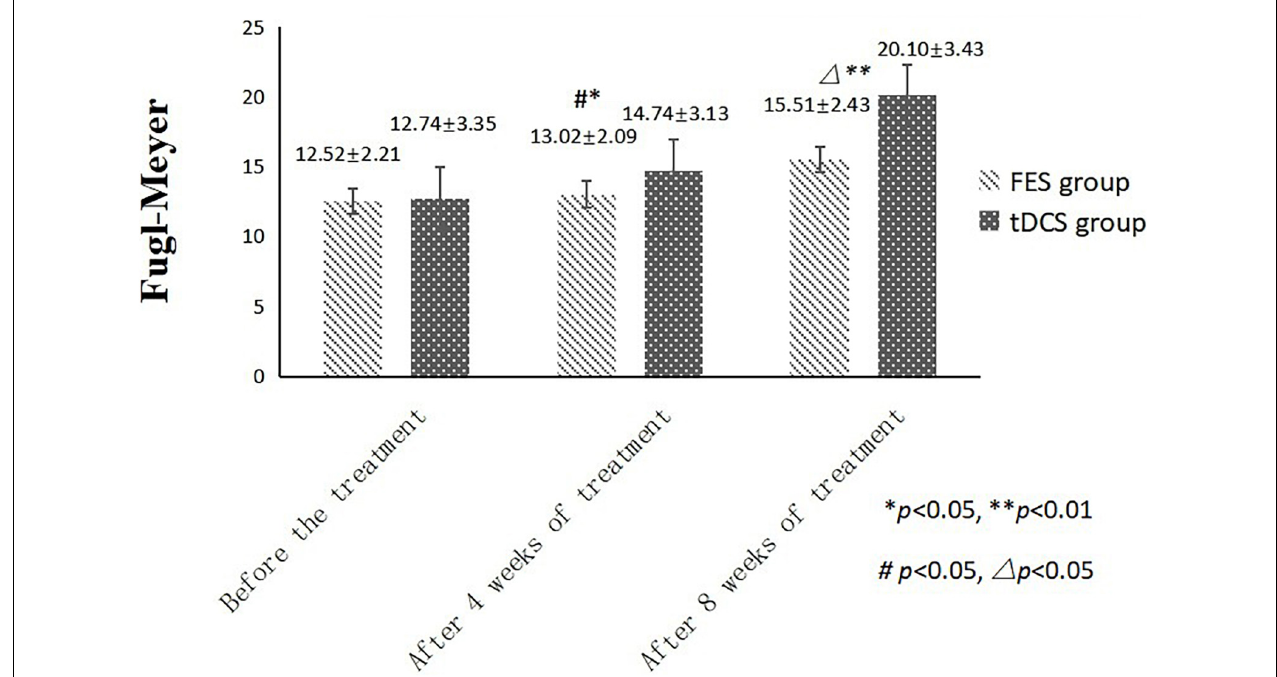
FIGURE 1 | FMA scores comparing improvement before treatment, and after 4 and 8 weeks of FES and tDCS treatments in post-convalescent stroke patients. ∗ Indicates that the mean value of the tDCS and FES groups is significantly different at the same time point, p < 0.05. ∗∗ Indicates that the mean value of the tDCS and FES groups is significantly different at the same time point, p < 0.01. # Indicates that the mean score after treatment is significantly different from that before treatment, p < 0.05. (cid:77) Indicates that the mean value difference at this time point is significant compared with that after 4 weeks of treatment, p < 0.05.